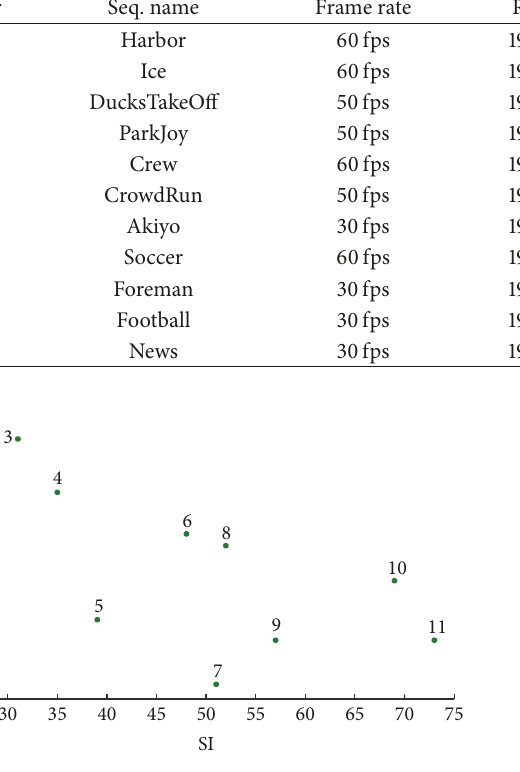
Figure 3: Calculated SI and TI values of chosen video sequences.